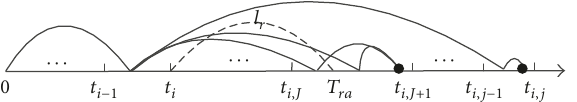
Figure 5: A delayed inspection replacement with an emergency ordered